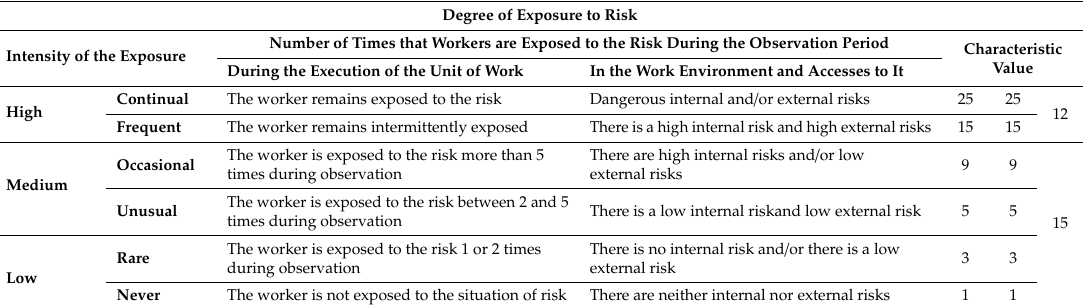
Table 6. Example of characteristic value in the degree of